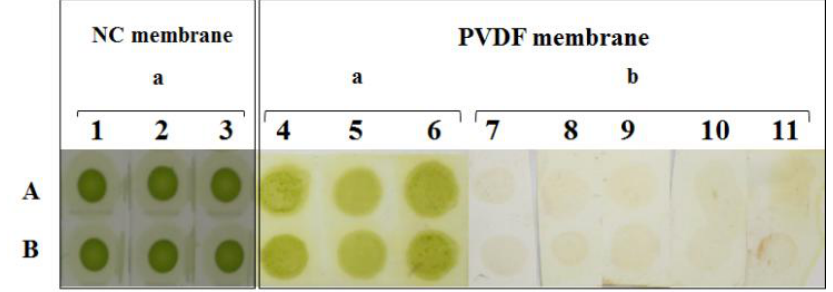
Figure 4. Effect of rice extract loading onto NC and PVDF membranes before and after washing. Numbers 1–3 represent the dry effect after loading the rice extract on the NC membrane. Numbers 4–6 represent the dry effect after loading the rice extract onto PVDF. Numbers 7–11 represent the washing effect of five kinds of organic solvent. A–B represent two repeats of the same experimental sample.